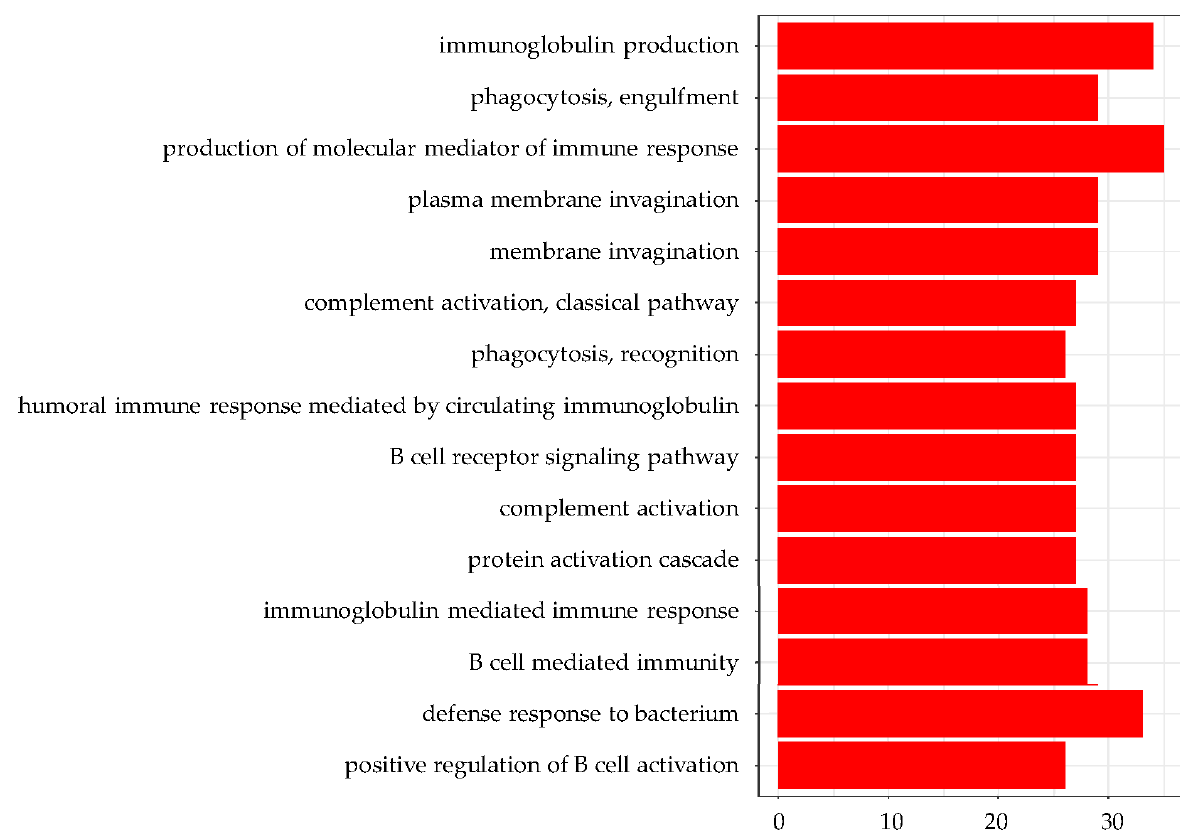
Figure 3. The top 15 GO terms from the Disease and Gene Annotations (DGAs) for upregulated genes in the liver.